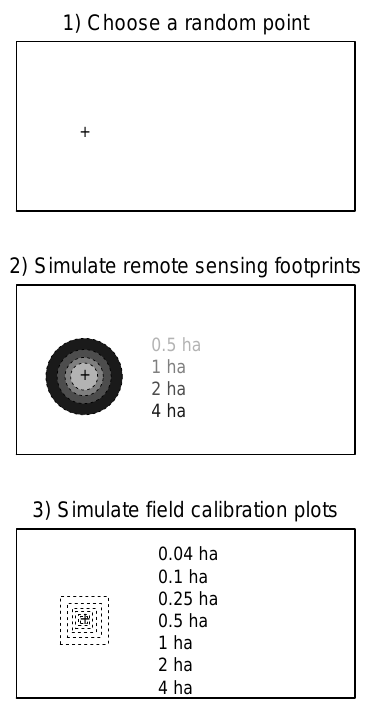
Figure 2. Schematic representation of the simulations used to as- sess expected errors when the calibration/validation plots and the re- mote sensing footprint differ in shape and size. (1) Within each large mapped plot, a point is chosen to be the centre of both the simulated remote sensing footprints and the simulated calibration subplots; it is chosen randomly from all points for which the largest foot- prints and calibration plots are fully inside the mapped large plot. (2) AGBD footprint is calculated within circular areas centred on this point, simulating the remote sensing footprint, for the listed sizes. (3) AGBD subplot is calculated within square areas centred on this point, simulating calibration/validation plots, for the listed sizes. We replicated this procedure 1000 times and then calculated the root mean squared error of AGBD subplot relative to AGBD footprint for each combination of areas in which the subplot area is less than or equal to the footprint area, and normalized by the mean AGBD footprint to obtain a measure of relative error specific to that combination of scales, ErrCV (see Eqs.